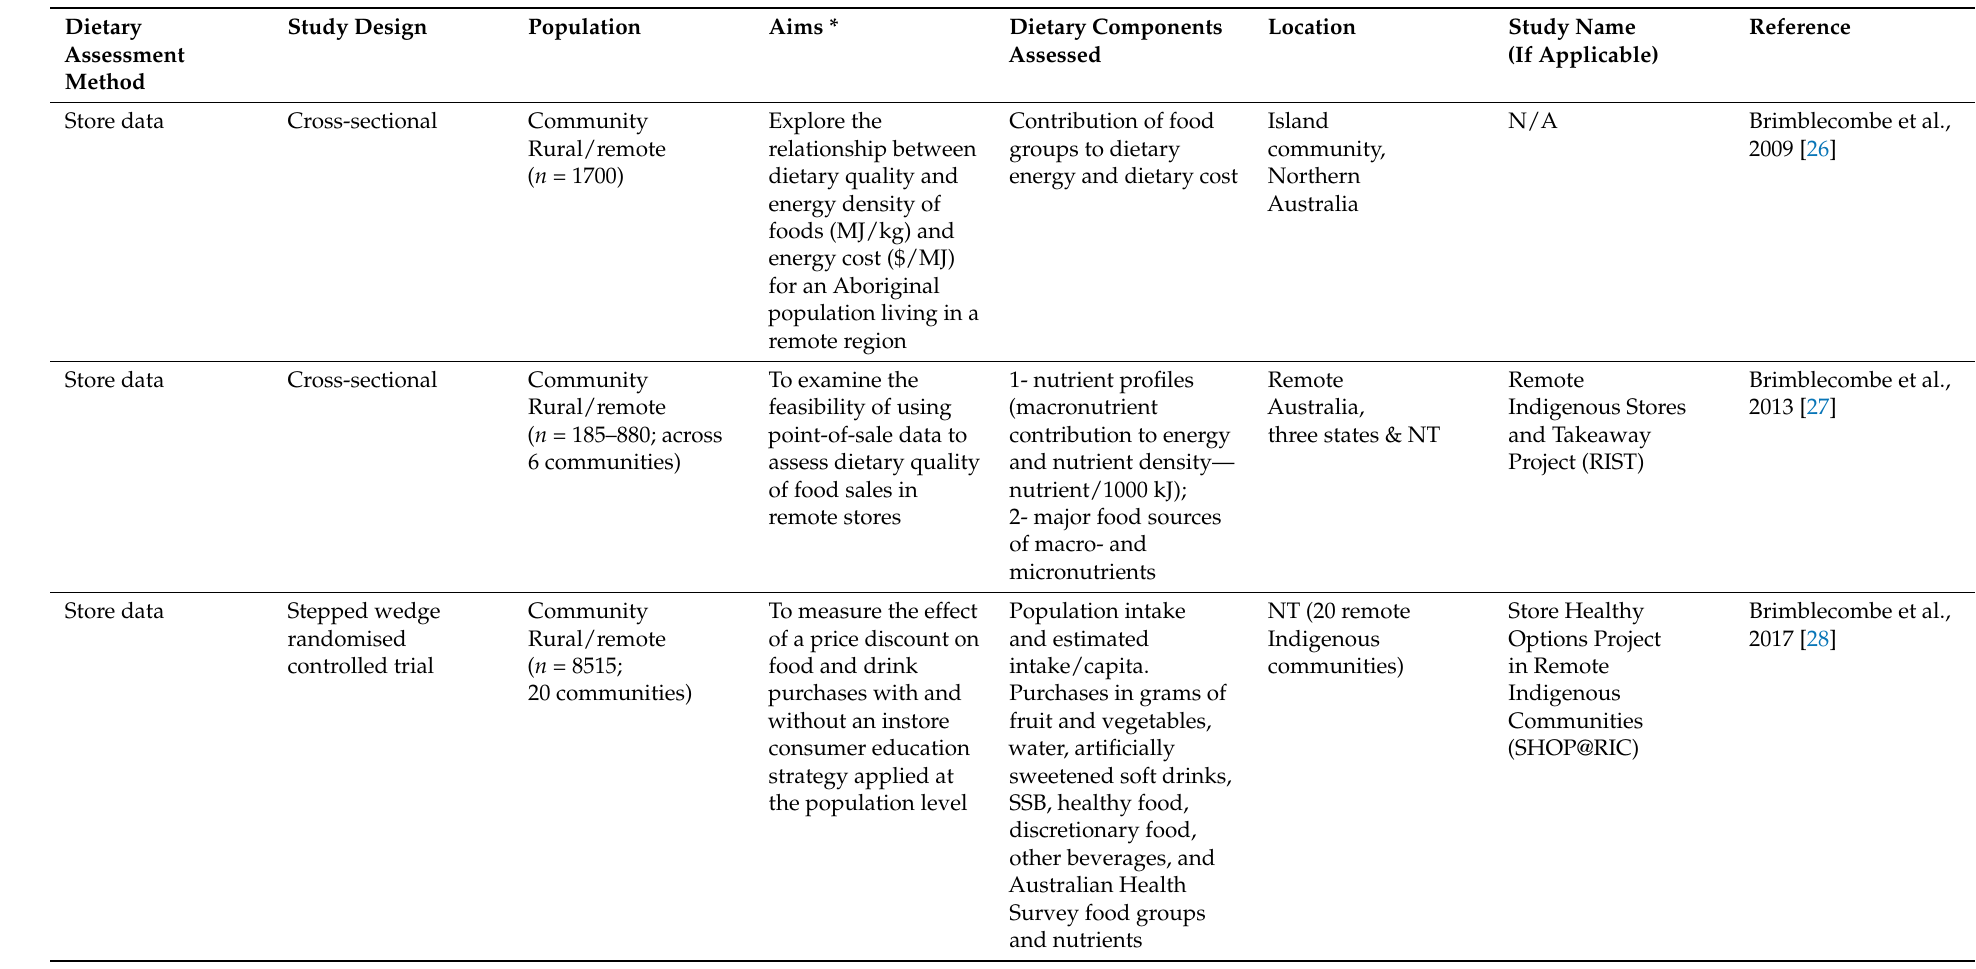
Table 1. Summary of the study characteristics of included studies of the applicability of dietary assessment methods in Aboriginal and Torres Strait Islander